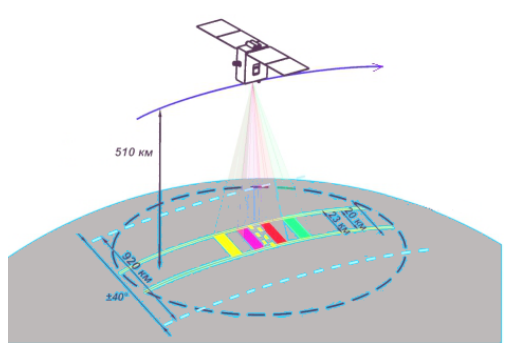
Figure 2. Shooting scheme of “Canopus-V” satellite.